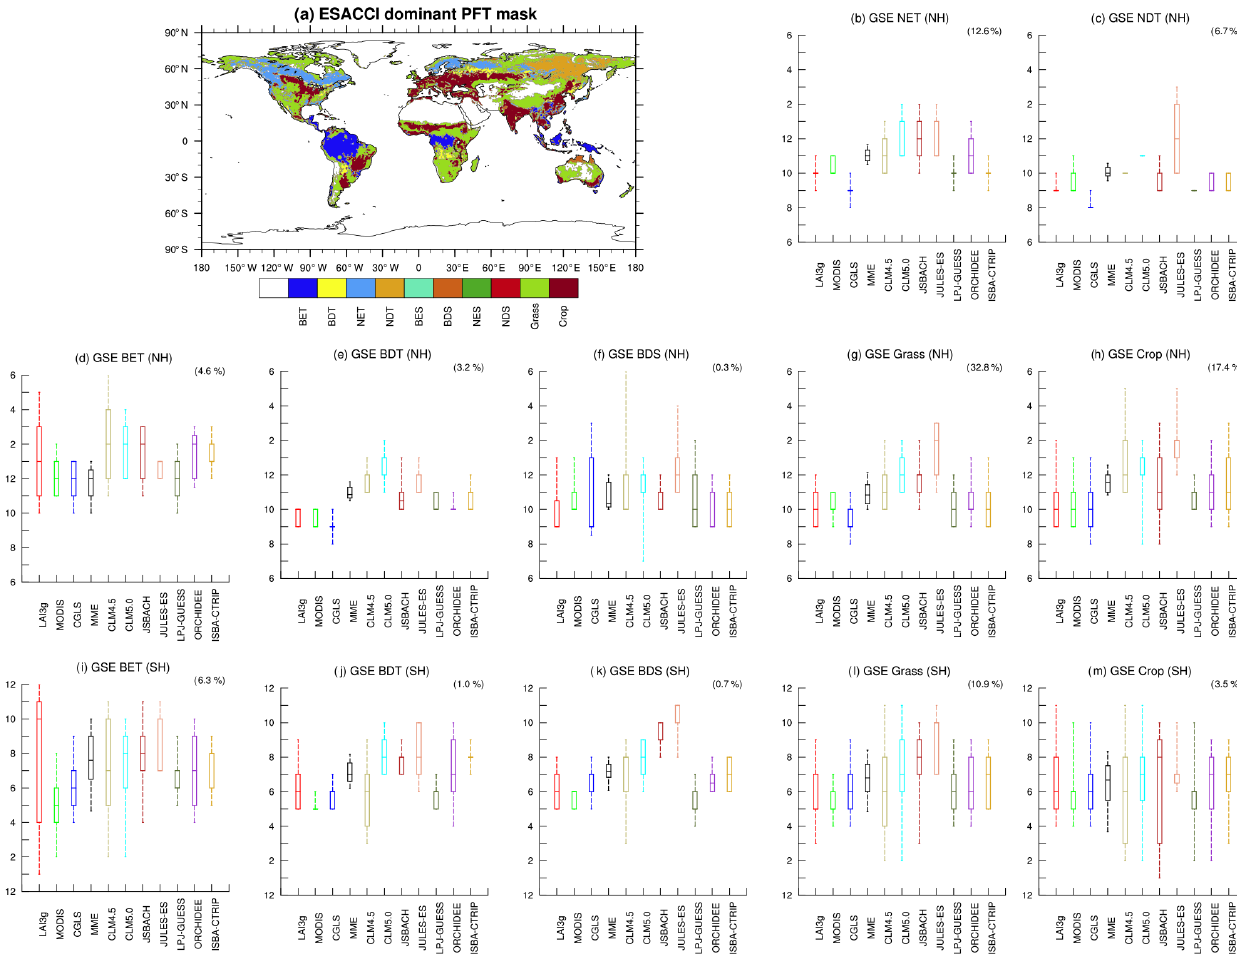
Figure 8. As Fig. 7 but for growing season end (GSE) timings. In this case, the winter season is central along the y